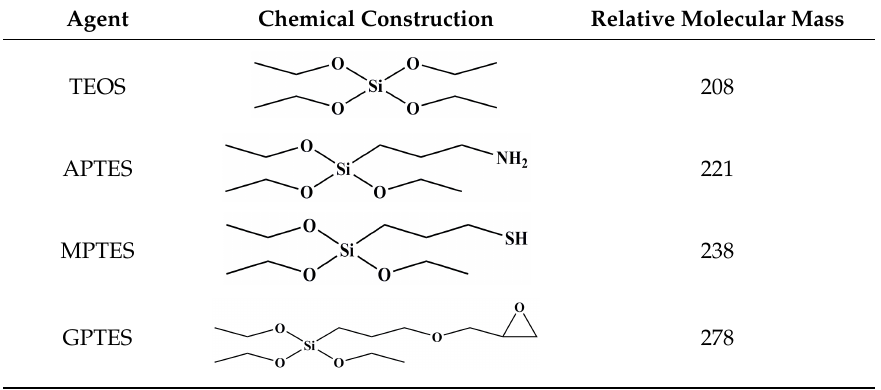
Table 1. Relative molecular mass and chemical structural formula of silane coupling agent.